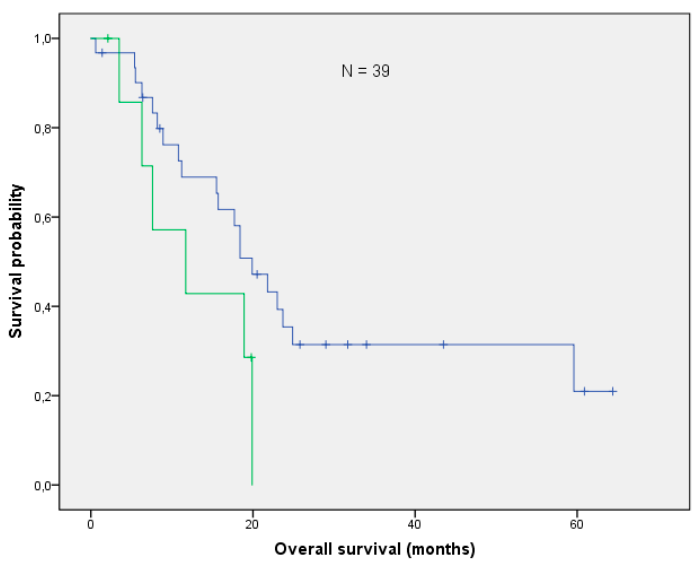
Figure 2. The median overall survival between patients with NSCLC (N = 31) and SCLC (N = 8) did not differ significantly (log-rank p -value: p = 0.101).